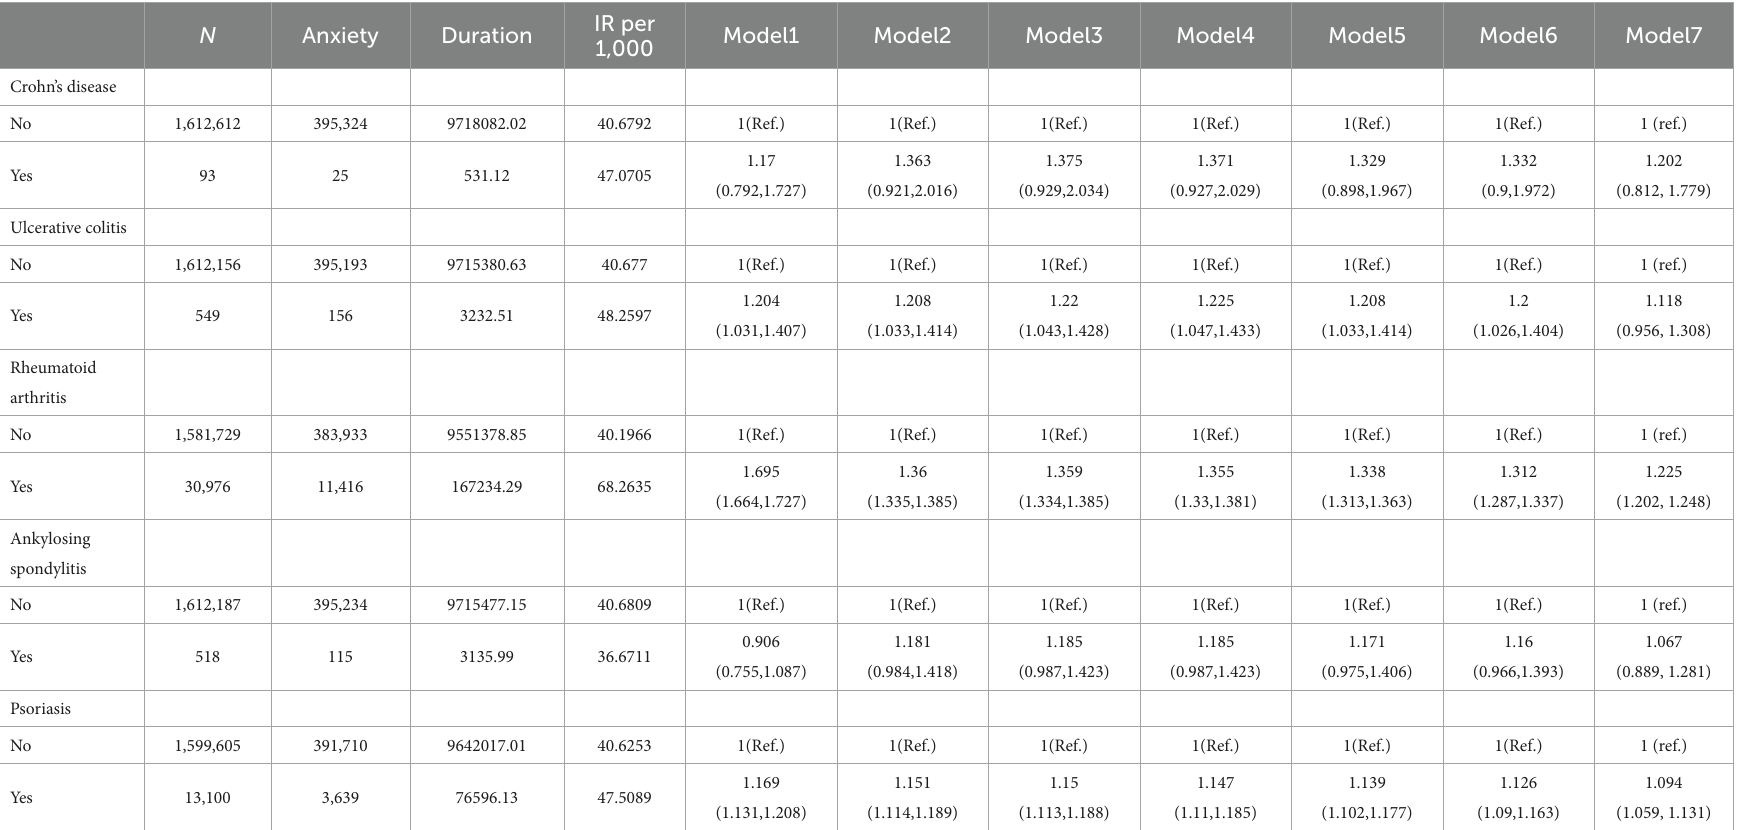
TABLE 5 Risk of anxiety according to the presence of individual immune-mediated inflammatory diseases.